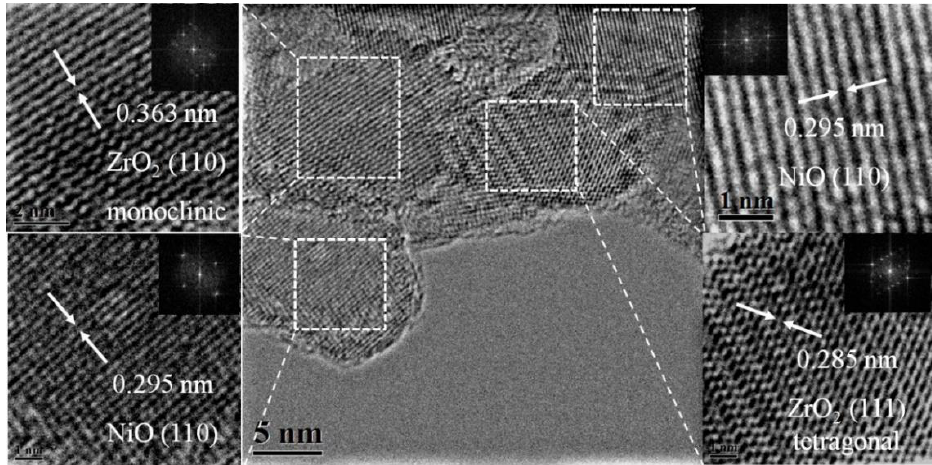
Figure 7. Transmission Electron Microscopy (TEM) and High-Resolution Transmission Electron Microscopy (HRTEM) images of 20% NiO/ZrO 2-COP-F catalyst. The white arrows correspond to the reflections. The inset shows the diffraction pattern showing these reflections.